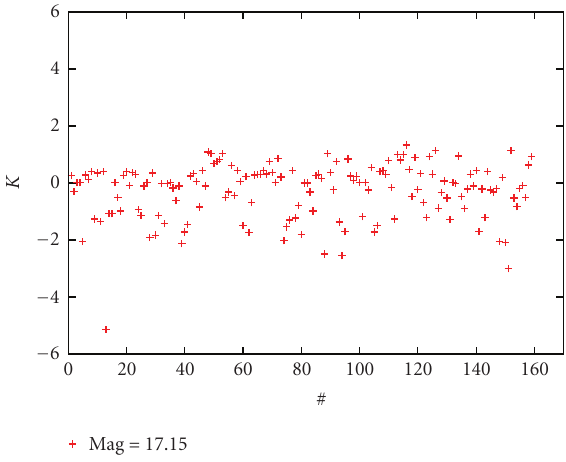
Figure 4: Faint source: uncertainty limited by the instrumental measurement.